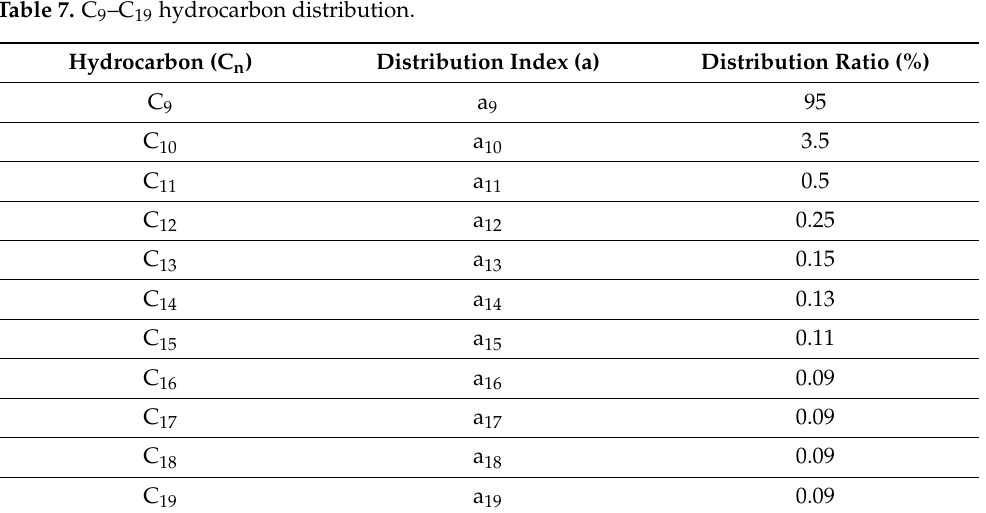
Table 7. C 9 –C 19 hydrocarbon